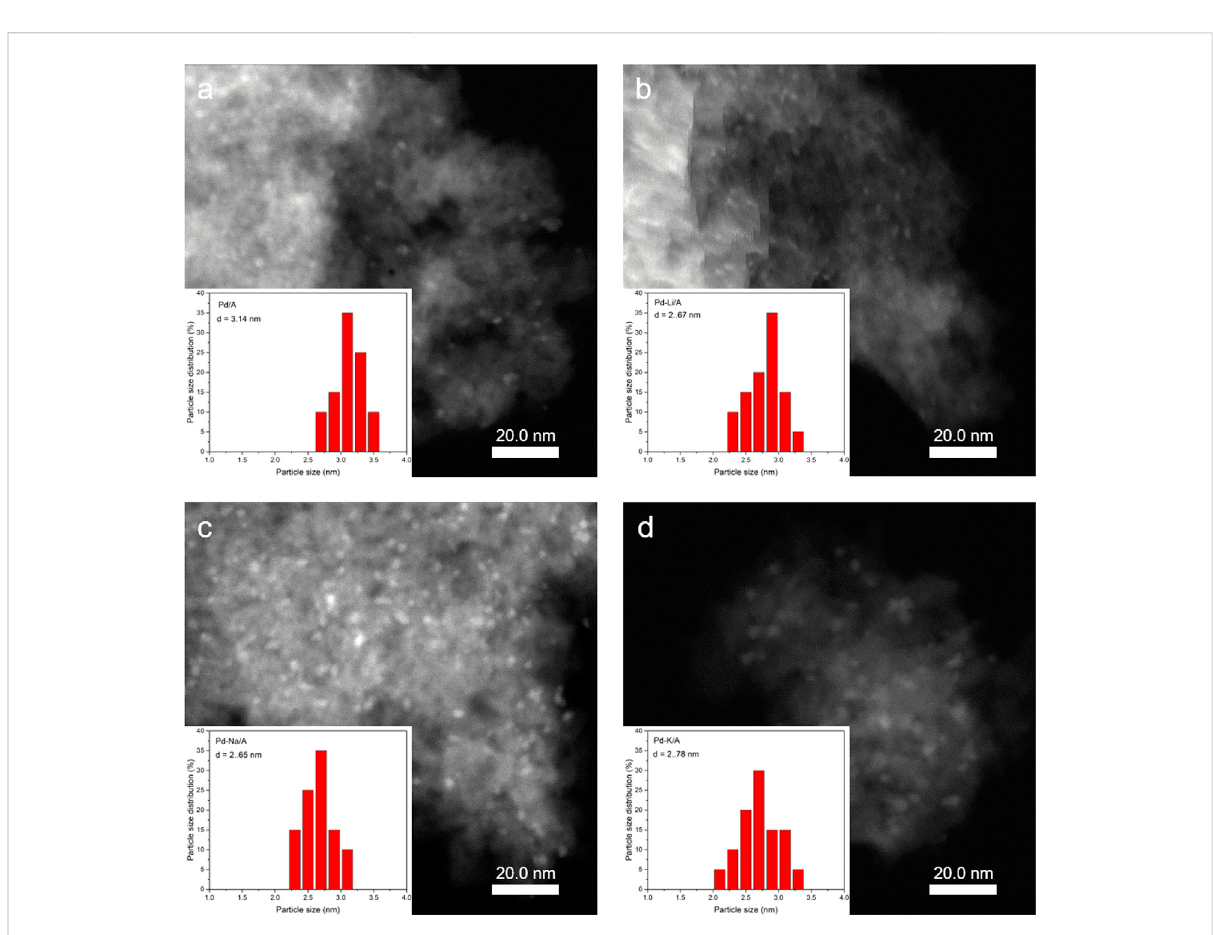
FIGURE 3 TEM images of (A) Pd/A, (B) Pd-Li/A, (C) Pd-Na/A, and (D) Pd-K/A